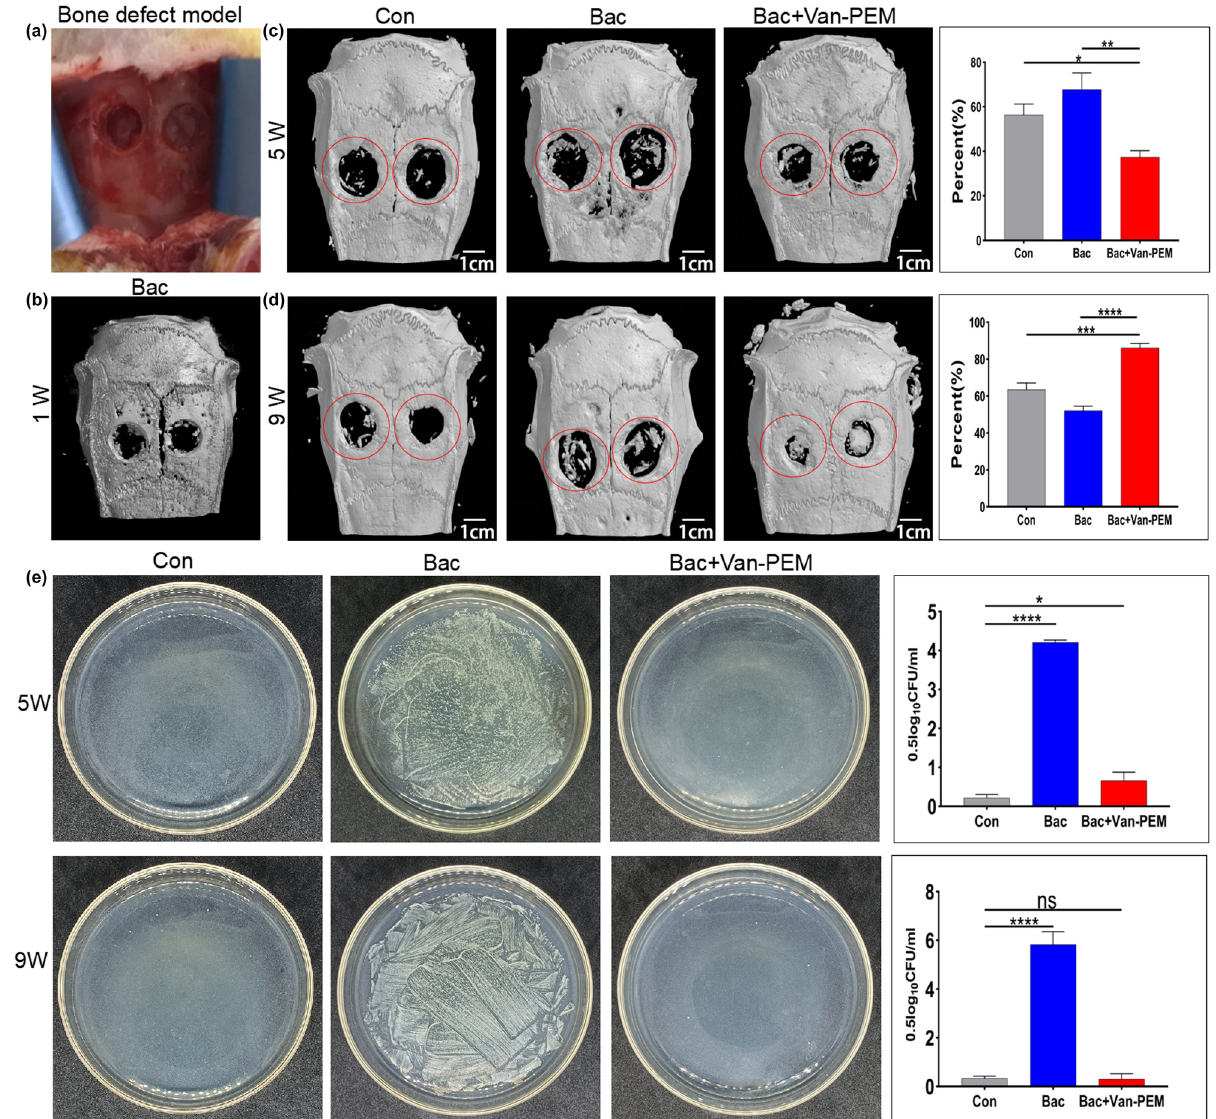
Figure 7: ( a ) Gross picture of the infectious skull defect model. ( b ) Micro - CT image of infection defect model 1 week after surgery. ( c ) Degree of skull erosion detected by micro - CT at 5 weeks after surgery. ( d ) Bone regeneration in the skull defect detected by micro - CT at 9 weeks after surgery. ( e ) Bacterial growth in the skull wounds of the control, bacteria - treated, and Van - PEM groups at 5 and 9 weeks after